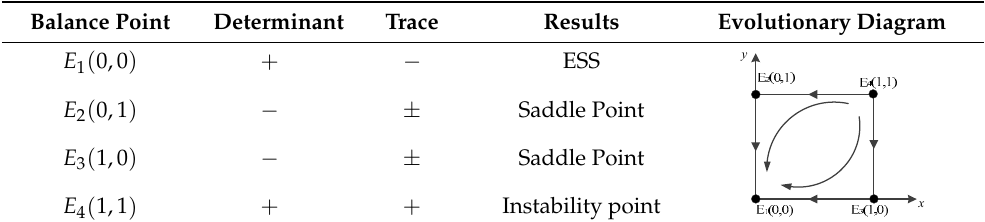
Table 4. Scenario 1 evolutionary game model steady state analysis. Balance Point Determinant